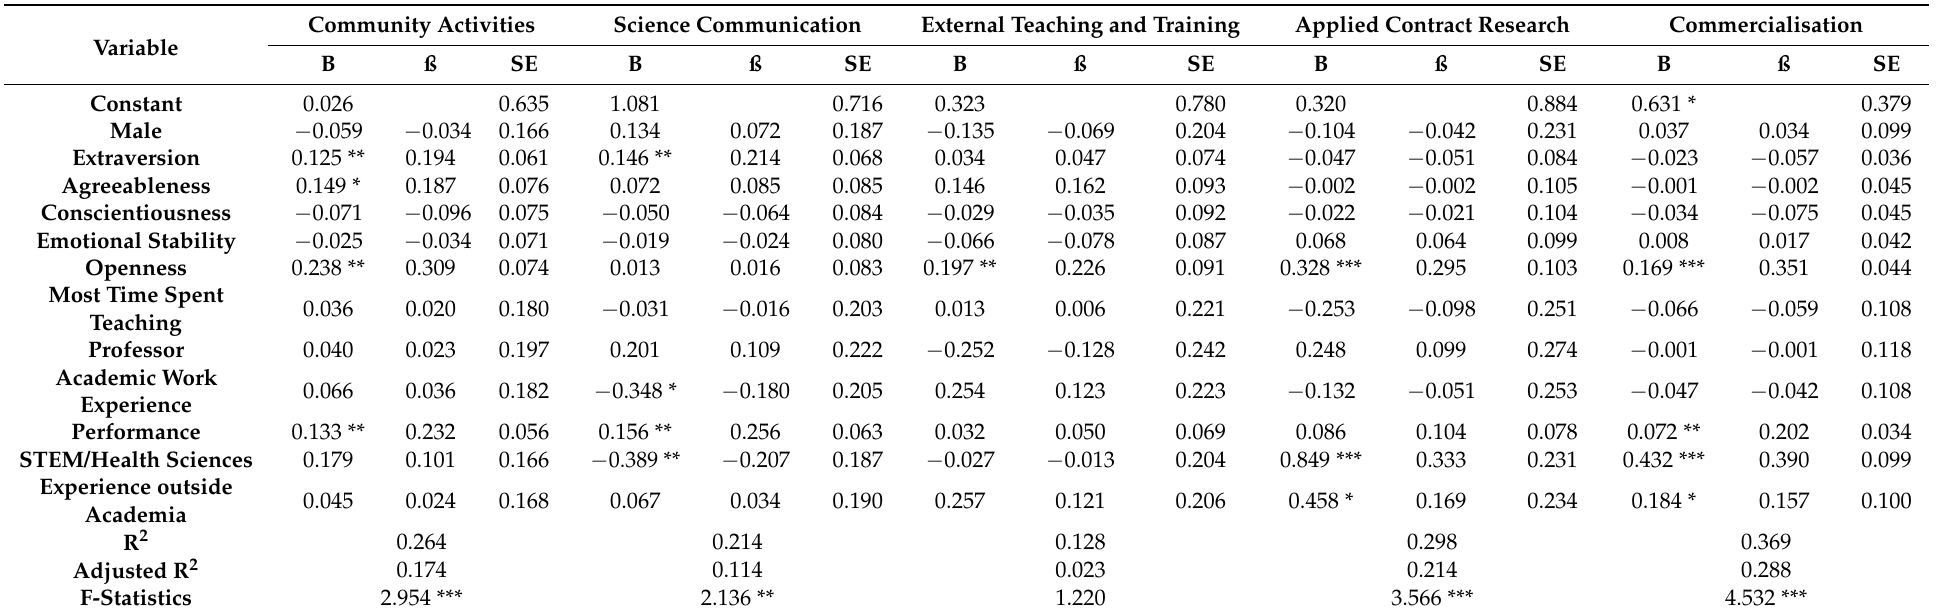
Table 5. Multiple regression models for predicting Third Mission